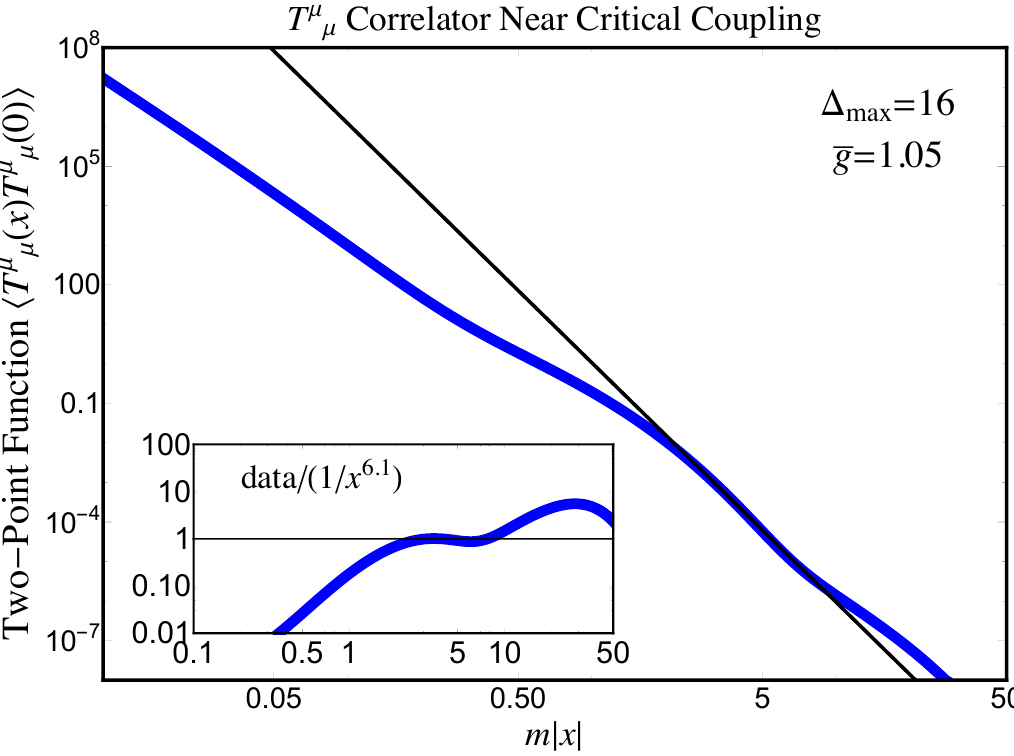
(cid:10) ( x ) T µ (0) (cid:11) at ¯ g = 1 . 05 . Black line shows the best fit in the T µ µ µ . Inset shows the data normalized by the power | x | 6 . 1